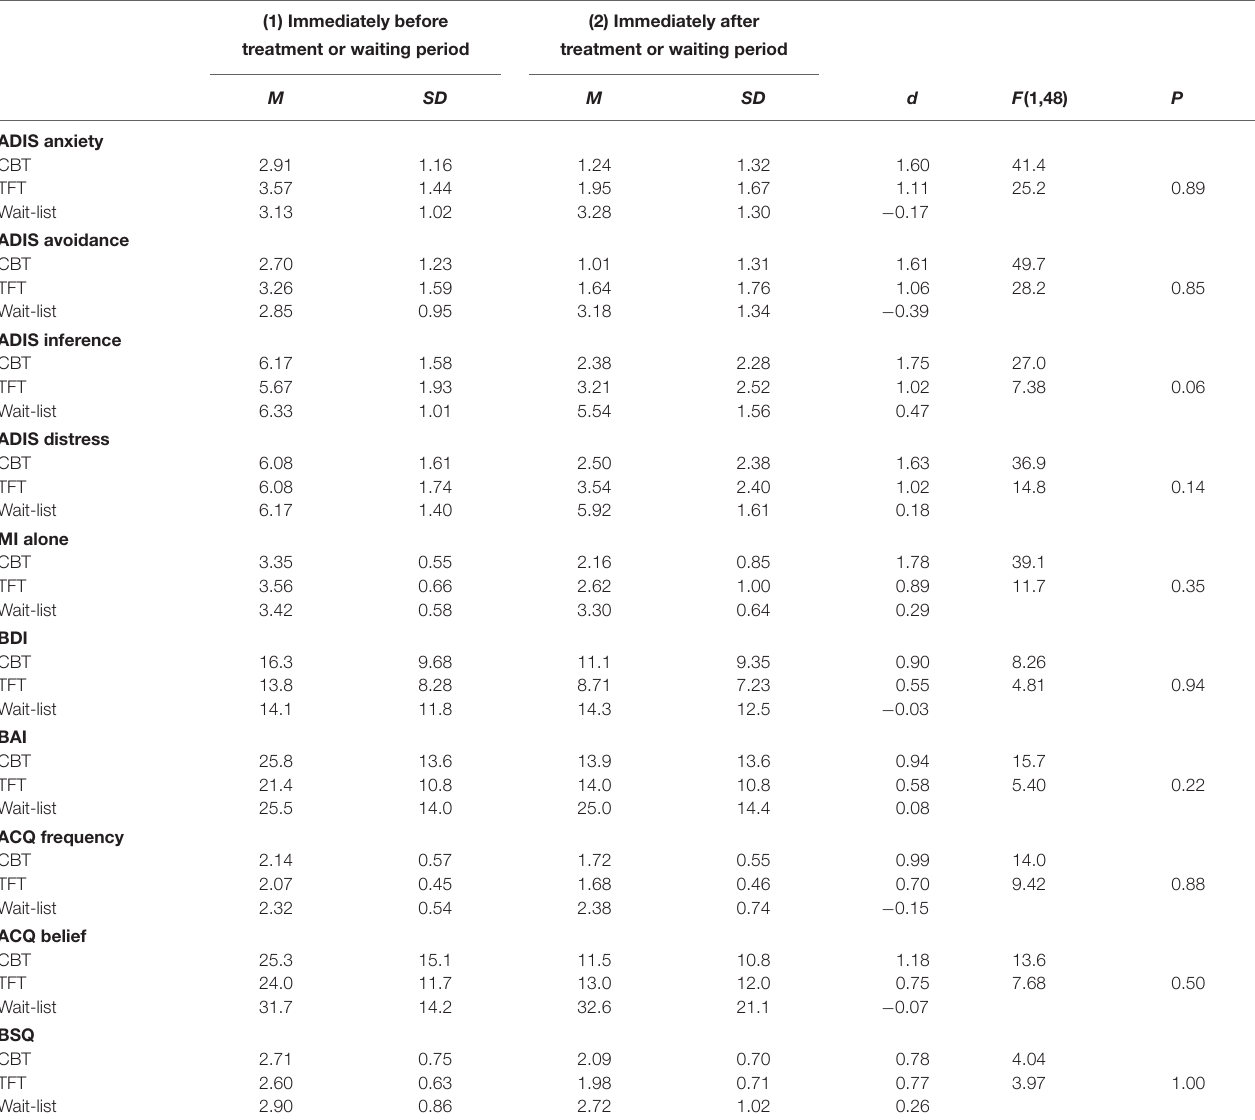
TABLE 3 | Mean, standard deviations, and effect sizes (Cohen’s d ) for patients randomized to treatment with (1) CBT 12 sessions ( n = 24) or (2) TFT five sessions ( n = 24), or (3) a 3 months wait-list ( n = 24), measured at baseline and after treatment or waiting period. F -values were computed for CBT and TFT in relation to wait-list, as a Condition × Time effect across the